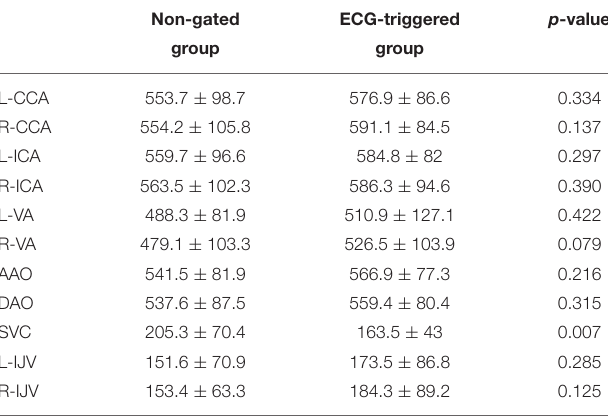
TABLE 2 | Quantitative analysis of image quality (vessel enhancement,